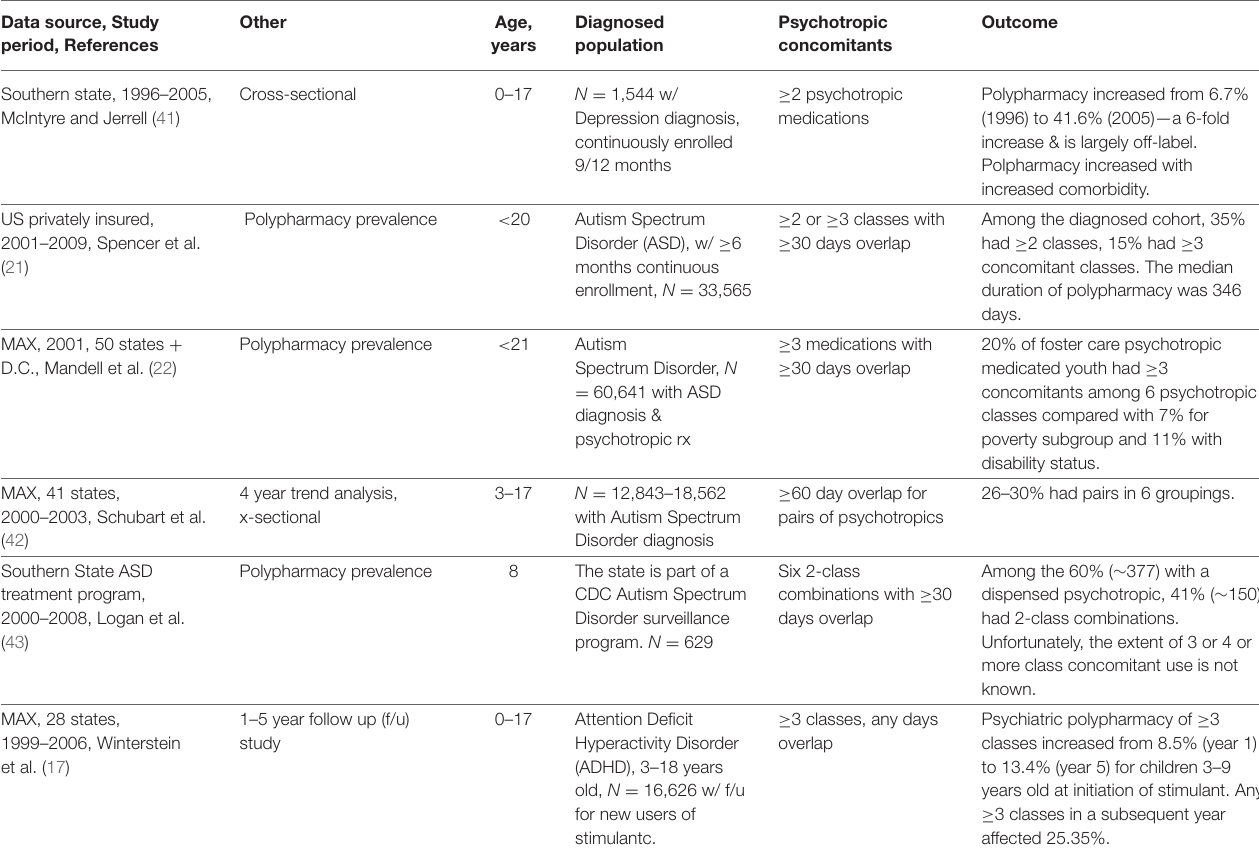
TABLE 4 | Pediatric psychotropic polypharmacy in diagnosed